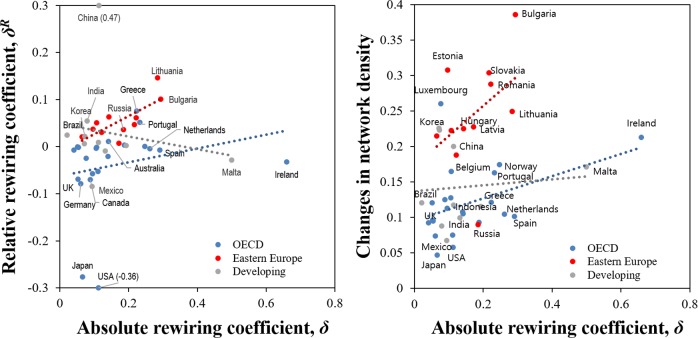
Relative vs. Absolute rewiring coefficients, 43 countries, 2000 to 2014.Early OECD member countries before 1990 (Blue) and Eastern Europe countries (Red) are highlighted. Other developing nations shown in gray.